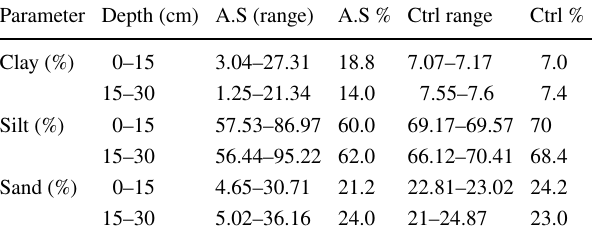
Table 5 Soil particle size distribution